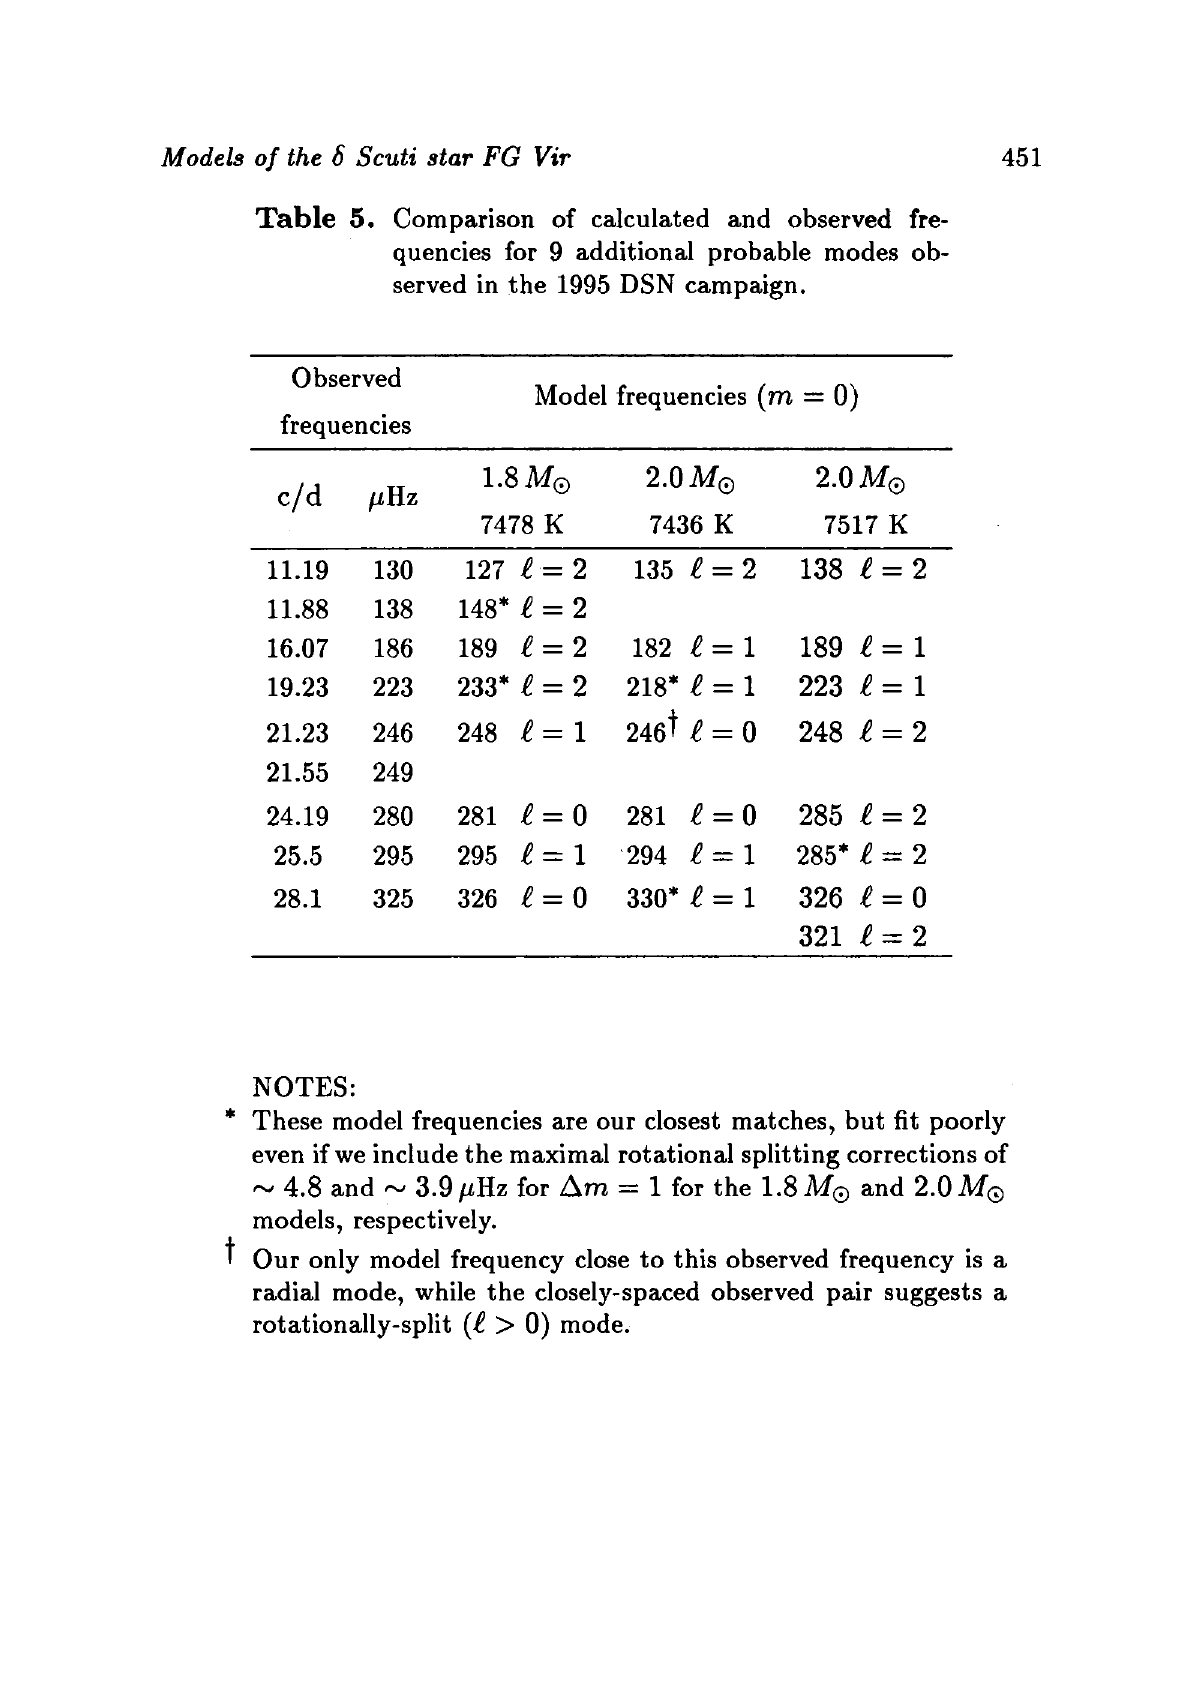
Table 5. Comparison of calculated and observed fre- quencies for 9 additional probable modes ob- served in the 1995 DSN